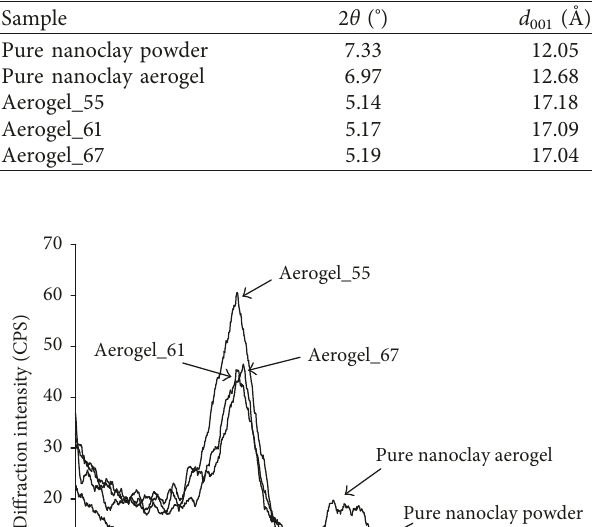
Table 2: Basal spacing of nanoclay aerogel masterbatches.